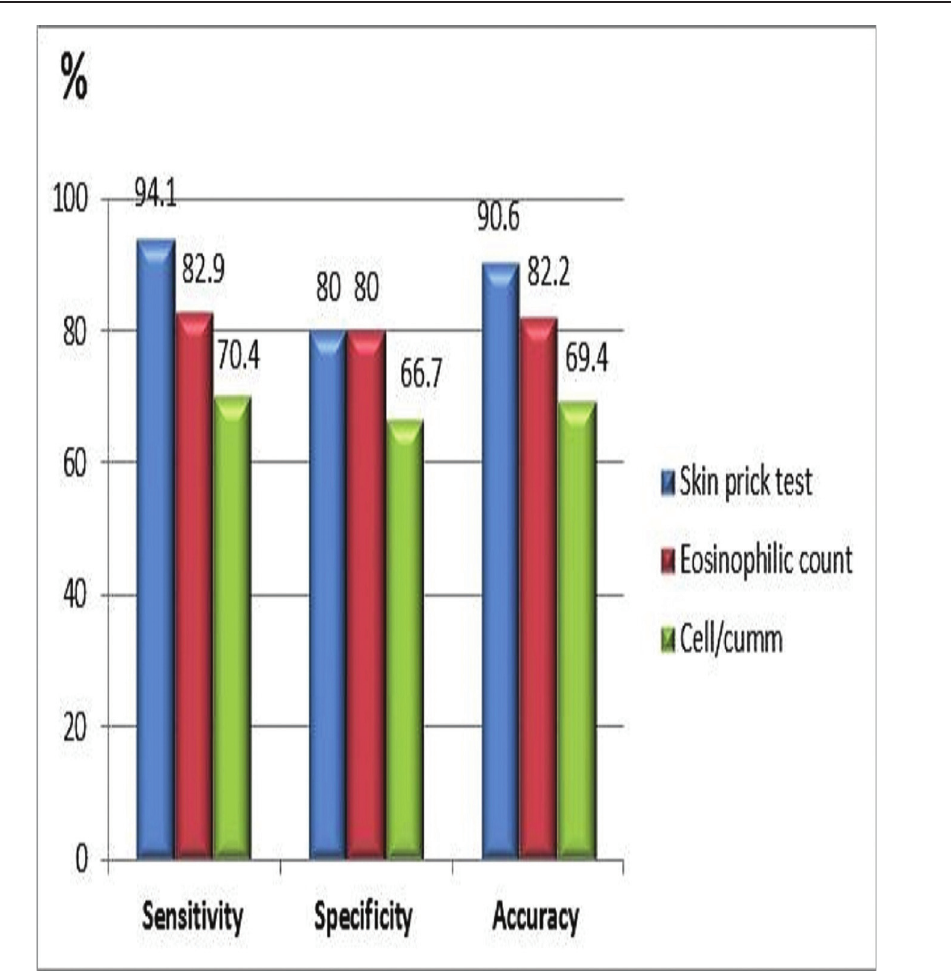
Sensitivity, specificity, and accuracy of SPT, AEC, and NSE. AEC, absolute eosinophil count; NSE, nasal smear eosinophilia; SPT, skin-prick